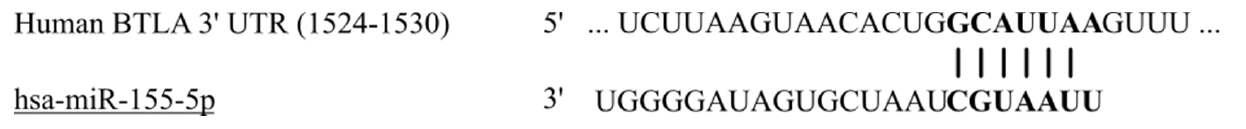
Figure 1. Predicted binding site of miR-155-5p in the 3′UTR of BTLA gene.